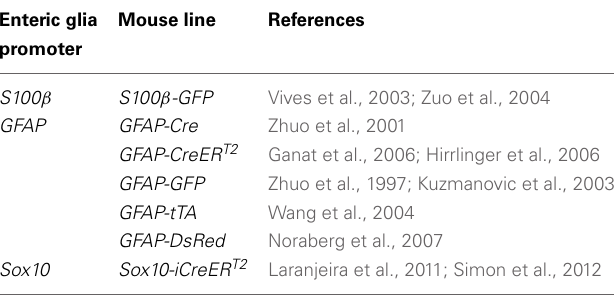
Table 1 | Non-exhaustive list of mouse lines that can be used to visualize enteric glial